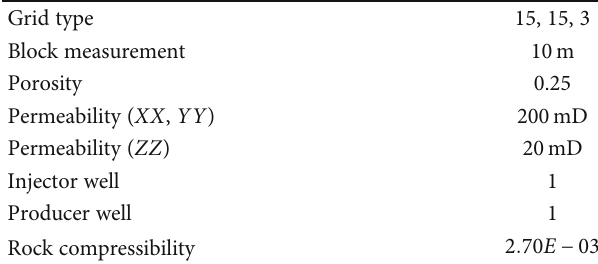
Table 1: Reservoir description.